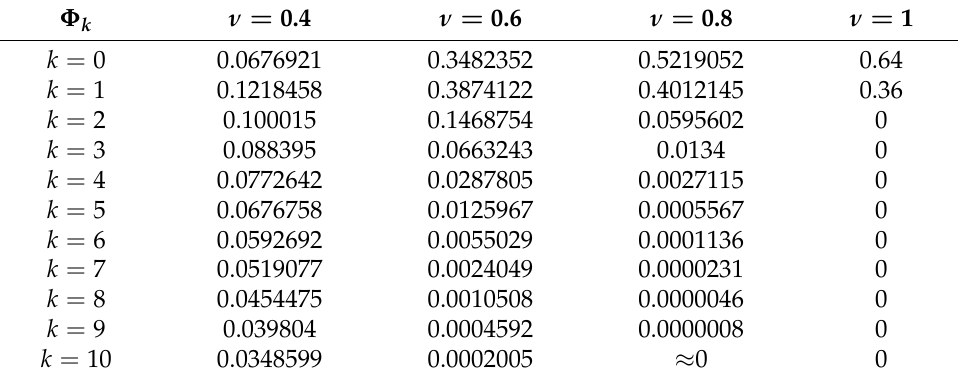
Table 2. The stationary distribution of the system size when a = 0.2, θ = 1, r = 0.3. Φ = k ν